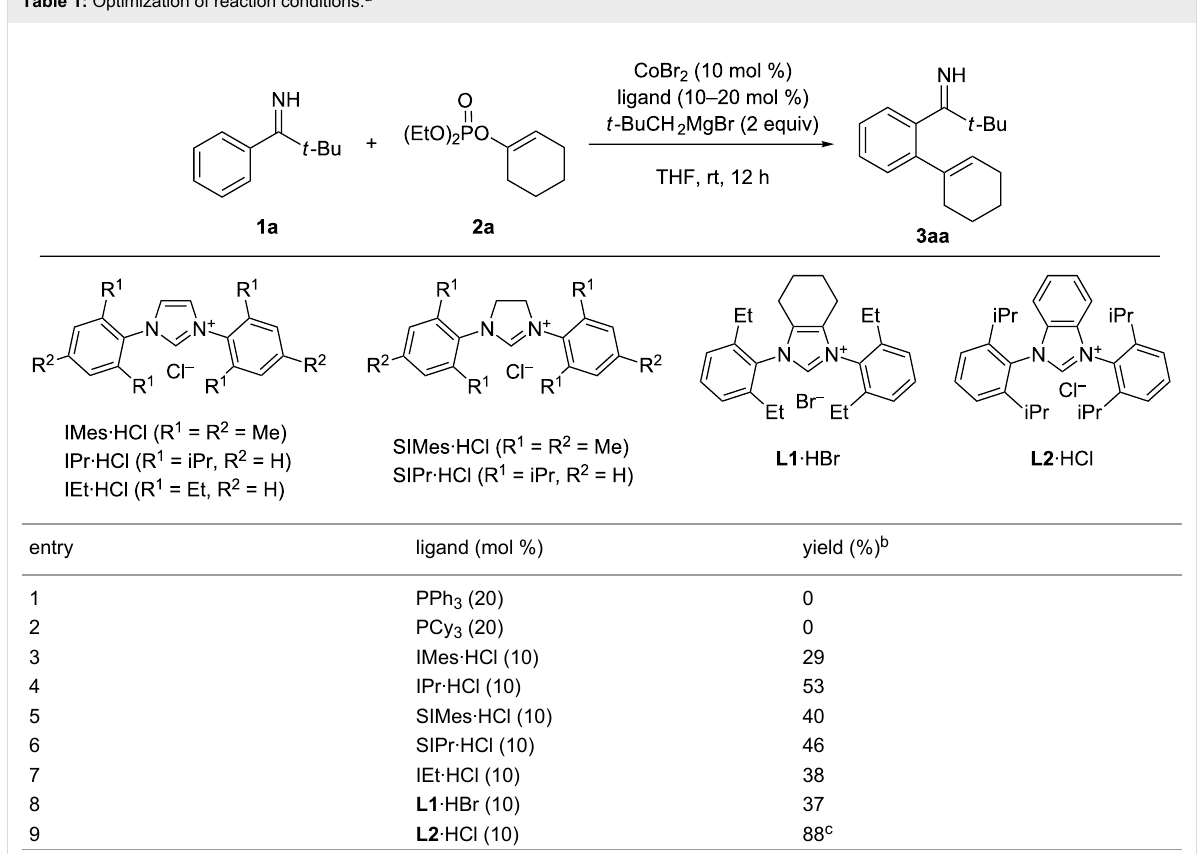
Table 1: Optimization of reaction conditions.